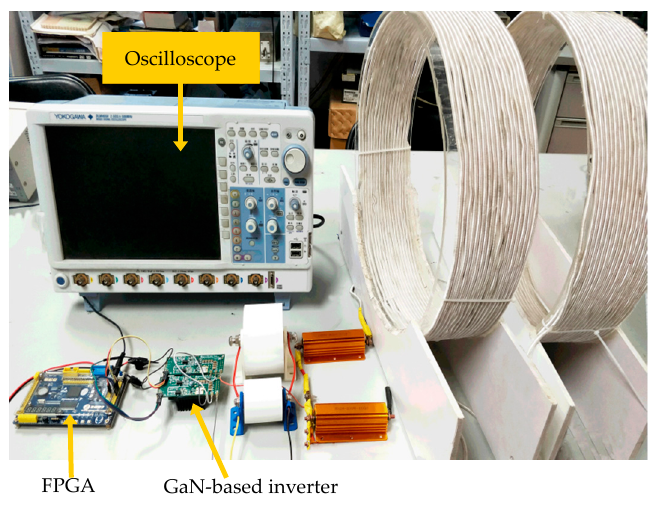
Figure 8. Experimental platform.